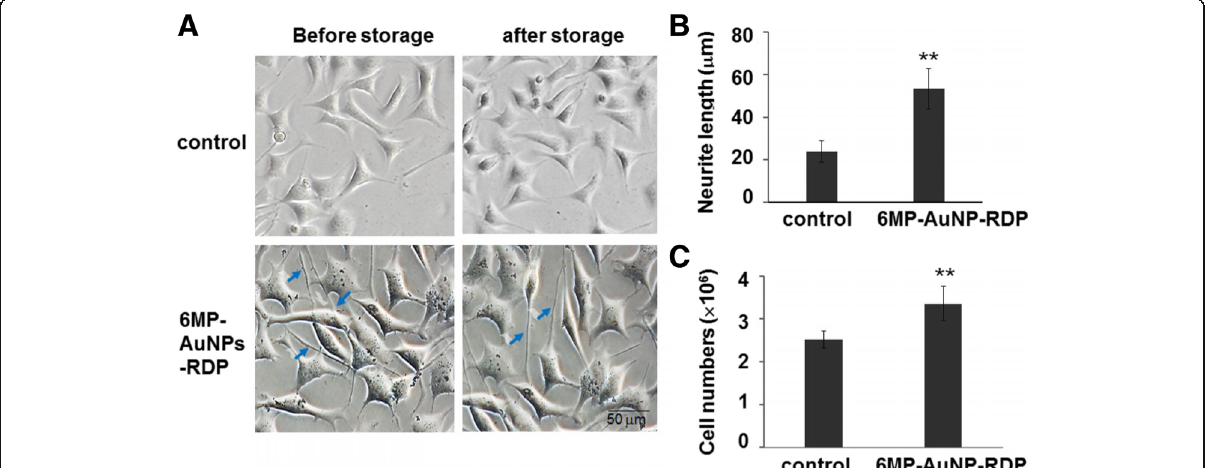
Fig. 7 The nanoparticle increased neurite length and cell numbers after frozen storage. ( a ) The cells were treated with 6MP-AuNPs-RDP (1.0 μ g/mL) before storage, and the cells were recovered and continued to culture for 3 days. Neurite length ( b ) and cell numbers ( c ) of 6MP-AuNPs-RDP-treated cells were significantly increased after storage. The cells with only solvent were used as control. Data are presented as mean±SEM. ** p <0.01 compared with the control. The blue arrow points to the representative